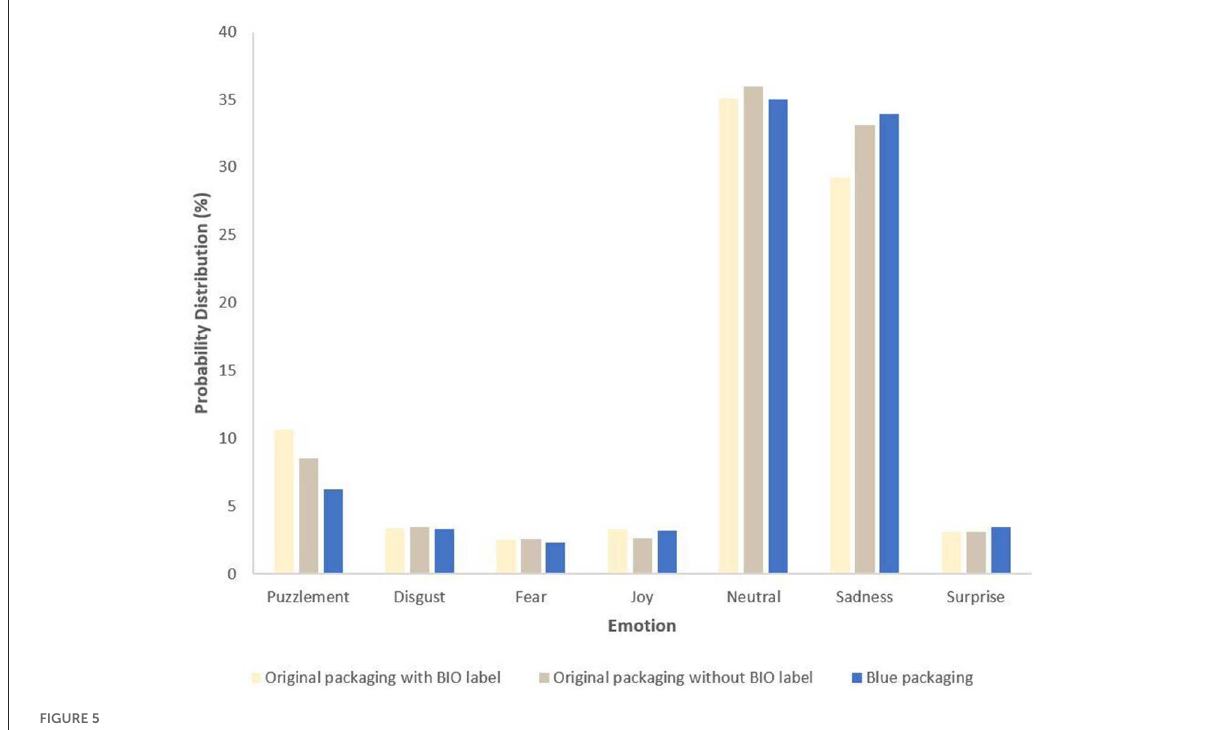
FIGURE5 Probability of elicited emotion when looking at Vegeta.